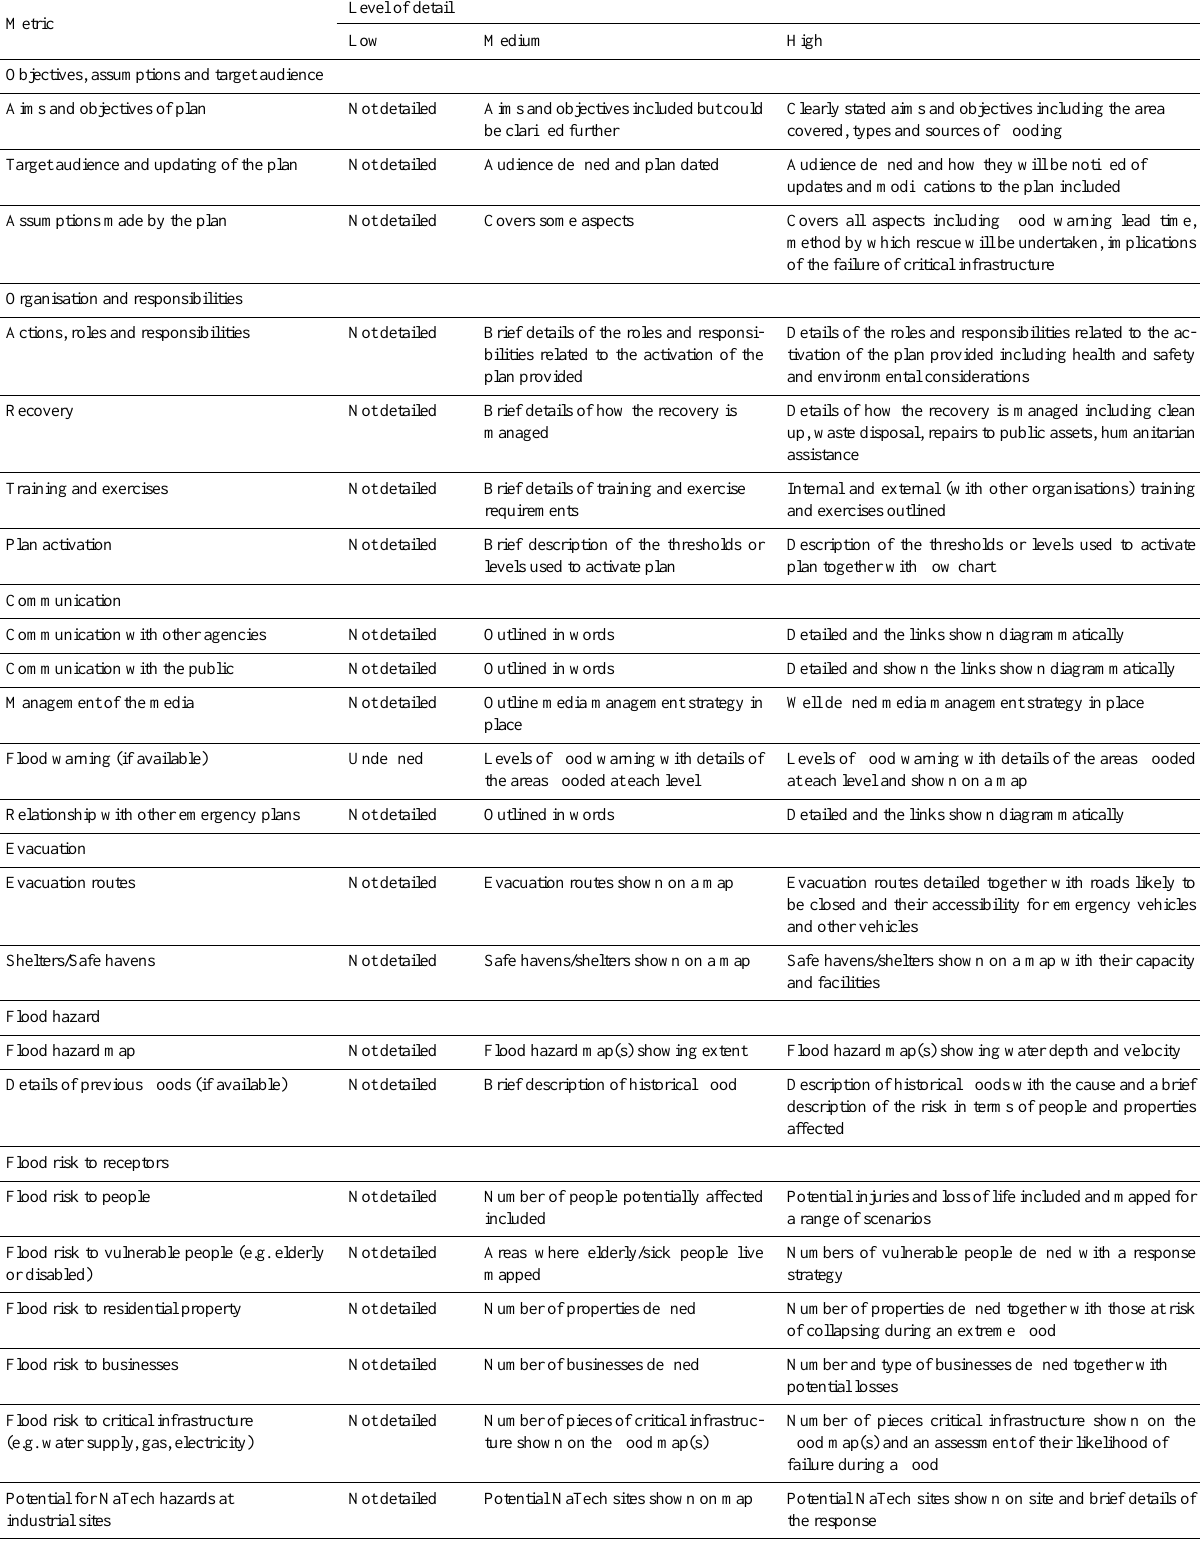
Table 1. Diagram of the FIM FRAME